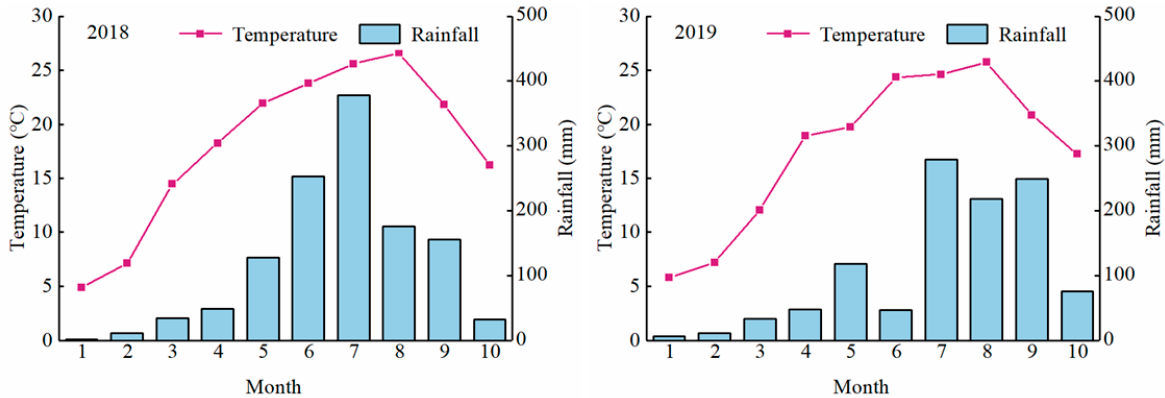
Figure 1. Meteorological data of the experimental area, including temperature and rainfall in 2017–2019.